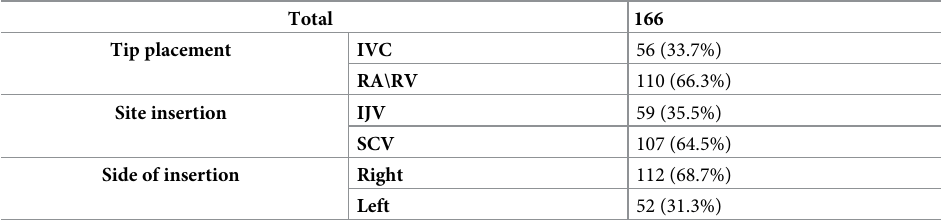
Table 2. Site and side of CVC insertion and wire migration